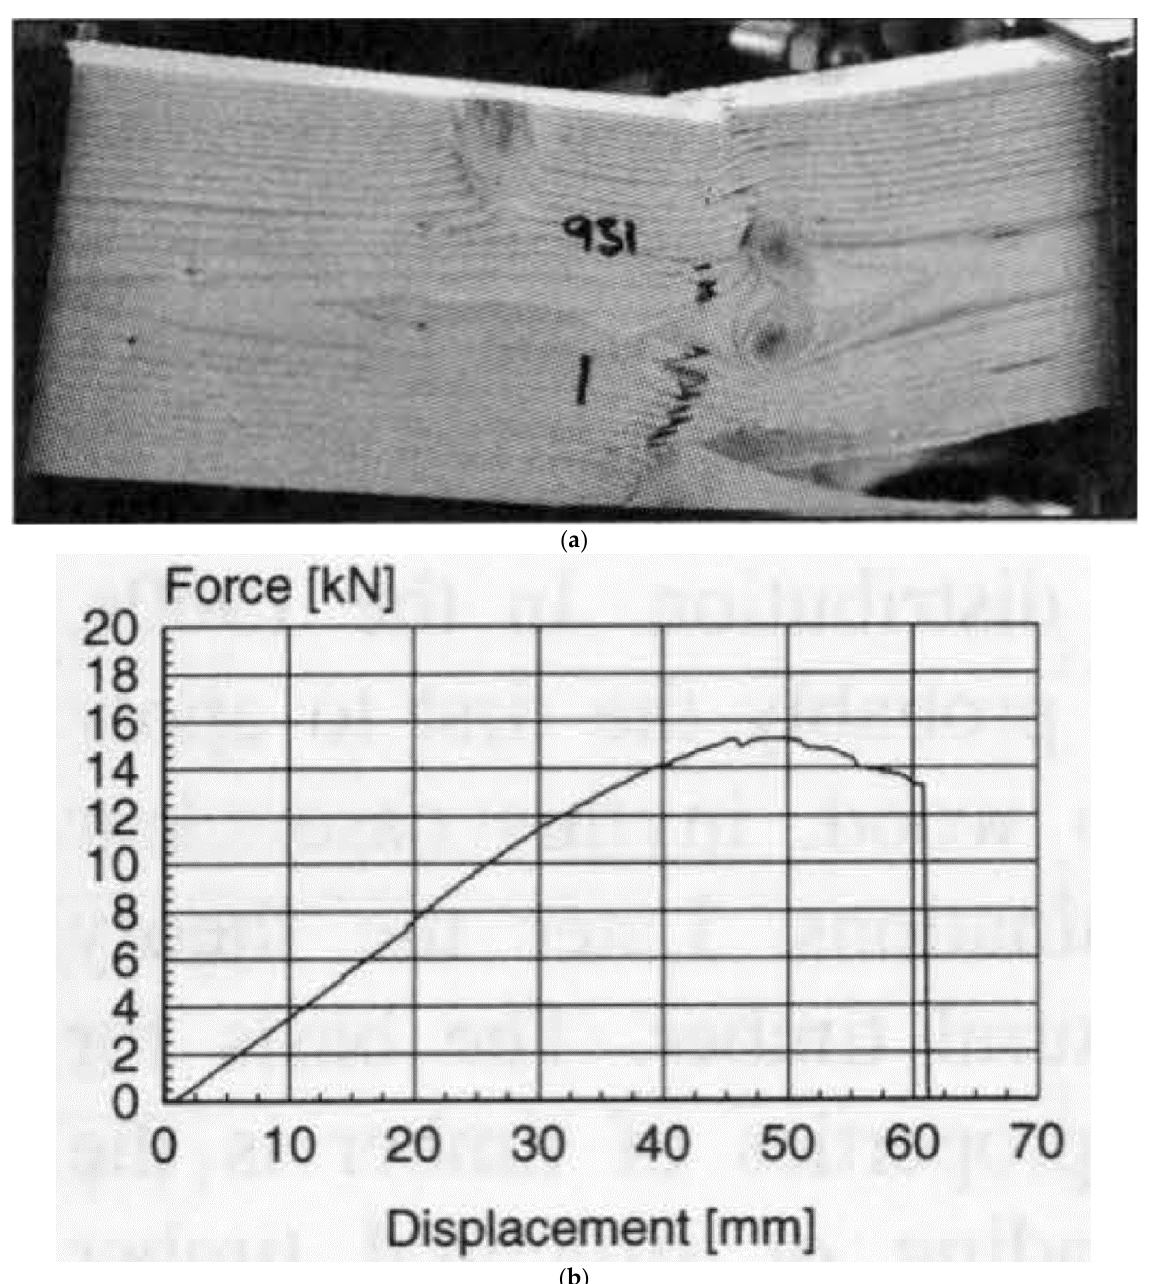
Figure 40. ( a ) Photograph of failed wood specimen that had been subjected to a bending load. ( b ) The load–displacement graph for the specimen shown in ( a ). The graph shows that plastic deformation occurred before failure, i.e., the failure was ductile. From [100].